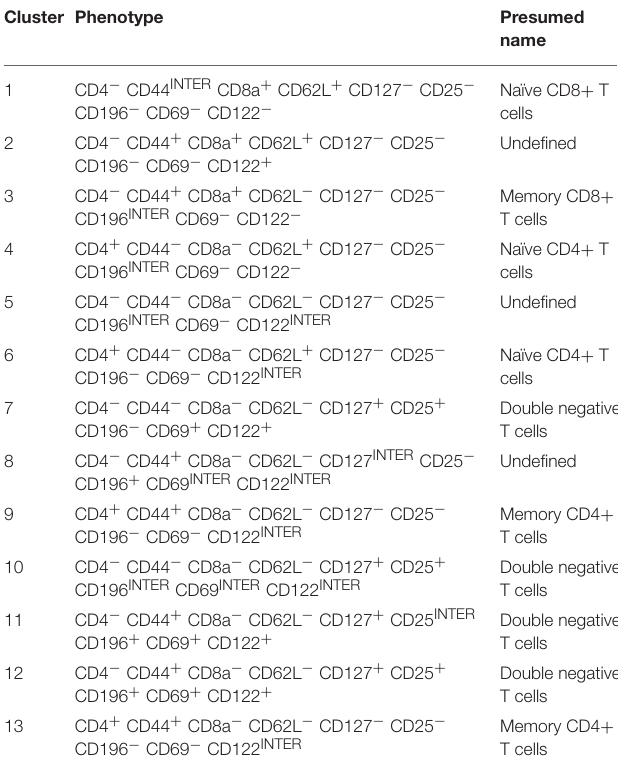
TABLE 3 | Presumed classification of TCR β + clusters ( Figure 7B ). Cluster